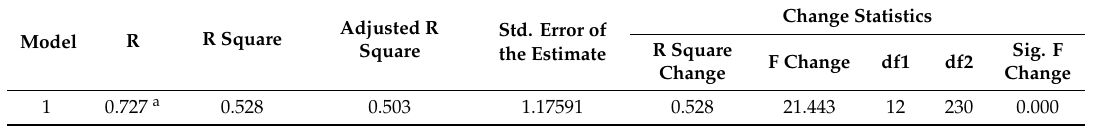
Table 11. Model Summary.